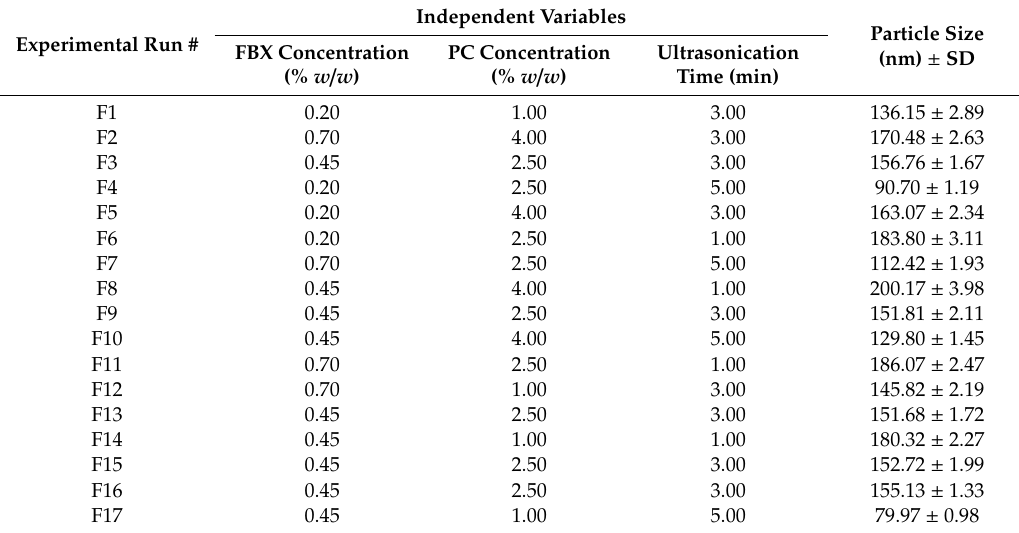
Table 2. Experimental runs, variables levels, and observed responses of FBX-EMLs prepared according to Box-Behnken